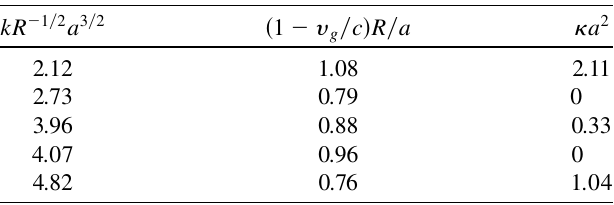
TABLE II. The lowest modes in a toroidal waveguide with the round cross section. The notations are the same as in Table I.